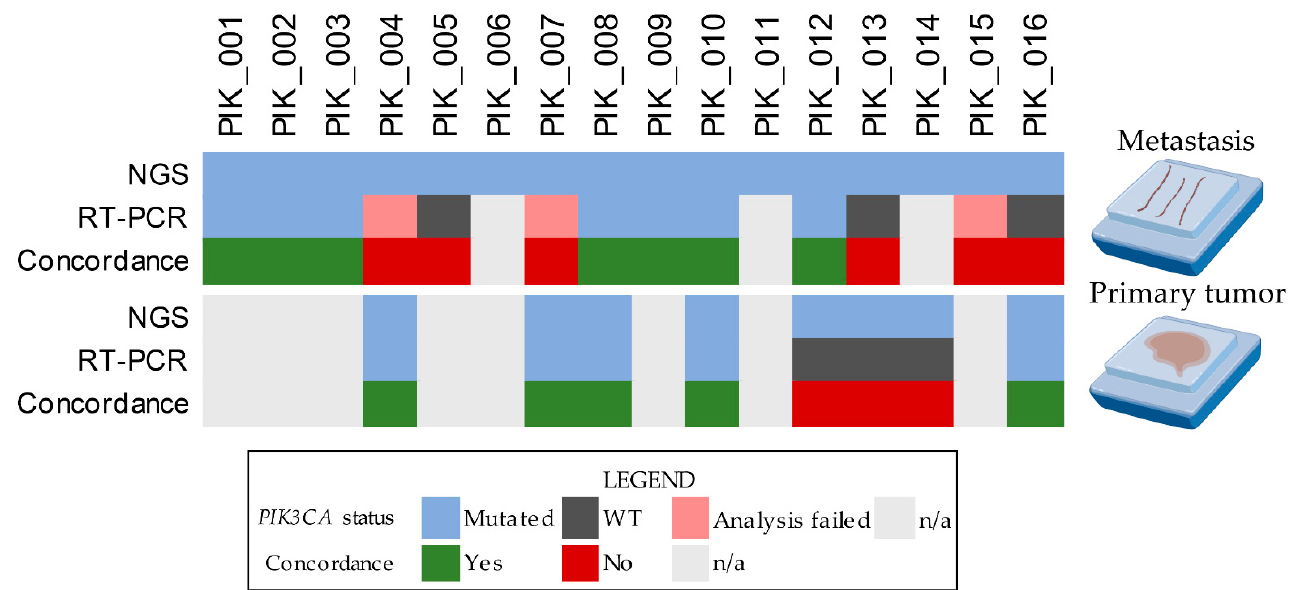
Figure 3. Heatmap illustrating the results of the analysis at a single-patient level for both primary tumors and metastasis samples. Each column represents a patient, and each row represents the type of assay with a concordance of both if applicable, color-coded according to the legend below . WT, wild-type; n/a, non-applicable.